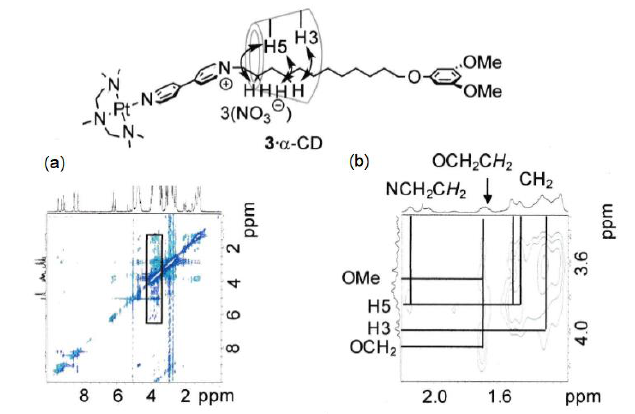
Figure 4. ROESY NMR spectra of [( 3 )· α -CD] 3+ (D 2 O, 25 °C, 500 MHz). Total spectrum ( a ) and expanded spectrum ( b ).